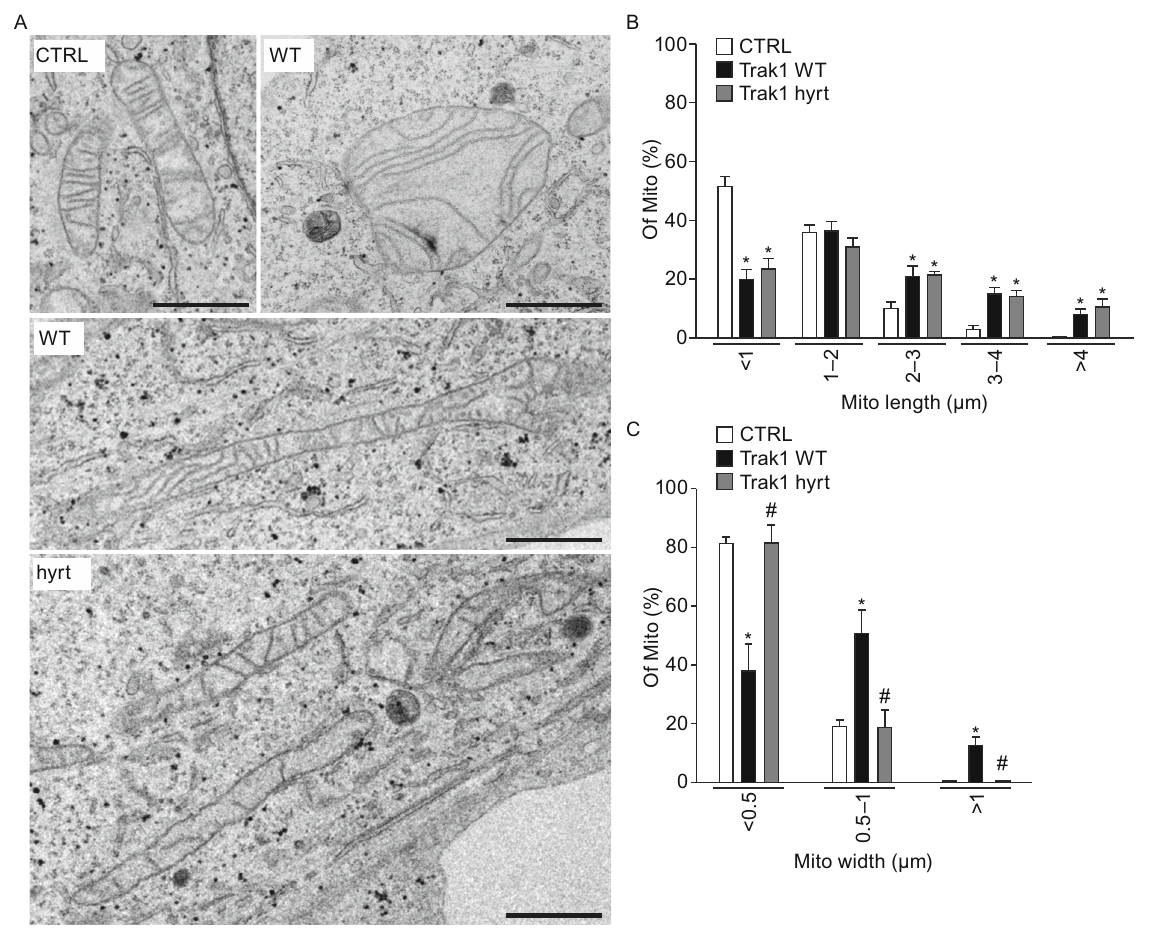
Figure 5. Mitochondrial ultrastructural changes caused by exogenous Trak1 WT and Trak1 hyrt expression. (A) Electron microscopic analysis of mitochondrial ultrastructure in GFP-tagged Trak1 WT- or Trak1 hyrt-transfected HeLa cells and mock- transfected controls (CTRL). Scale bars: 1 μ m. (B and C) The percentages of mitochondria with different ranges of mitochondrial length (B) or mitochondrial width (C) were quanti fi ed and shown as mean ± SEM ( n = 6). In total, 299 (CTRL), 157 (Trak1 WT), and 173 (Trak1 hyrt) mitochondria were analyzed. *, P < 0.05 versus the corresponding CTRL; #, P < 0.05 versus the corresponding Trak1 WT, one-way analysis of variance with a Tukey ’ s post hoc